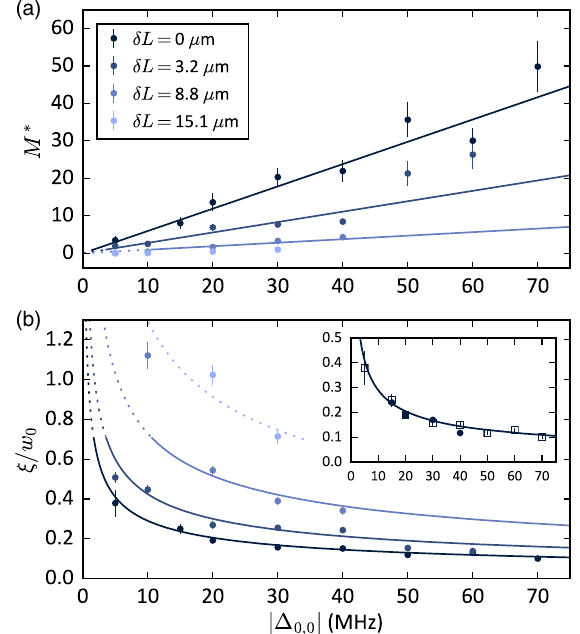
FIG. 6. Absorption images in time-of-flight expansion of two intracavity BECs located on opposite sides of the cavity at x 1 and x 2 . The image is not purely of a momentum distribution because of the short time of flight. The images show the contributions from each BEC along with the diffraction peaks from each gas. (a) Time-of-flight expansion with no transverse pumping ( Ω ¼ 0 ). In this and the subsequent panels, the left BEC has 60% fewer atoms than the one on the right. (b) Time-of-flight expansion for a spacing of x 1 ¼ − x 2 ; i.e., each real BEC spatially overlaps with the other BEC ’ s virtual image. The BECs self- organize at the same threshold pump Rabi frequency Ω ¼ Ω 0 First-order Bragg peaks are visible for both the left BEC (red dashed circles) and right BEC (white dashed circles), heralding self-organization [28]. Additional diffraction peaks from the standing-wave pump beam are found to the left and right of each BEC. (c) Separating the BECs from each other ’ s virtual image by 32 . 4 μ m, close to a cavity waist w 0 , reduces the interaction energy, causing the small BEC to be unable to reach threshold at the same pump power as the larger BEC. [ Ω ¼ Ω 0 the same as in panel (b).] That is, the larger (smaller) BEC at right (left) exhibits (no) Bragg peaks, indicting (no) self-organization into a checkerboard lattice. The color scale has been increased in panels (b) and (c) with respect to panel (a) to make the Bragg peaks more